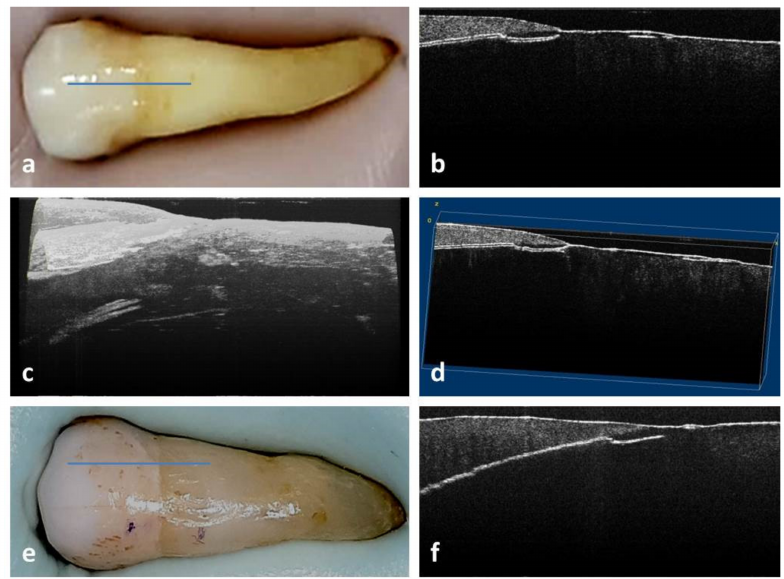
Figure 2. PM2 examination: ( a ) macroscopic aspect of buccal surface; ( b ) 2D OCT image of buccal area with crack at enamel–dentin junction; ( c ) 3D image of buccal surface in the cervical area; ( d ) 3D volume viewer image of buccal surface in the cervical area; ( e ) macroscopic aspect of oral surface; ( f ) 2D OCT image of oral area with crack at the enamel–dentin